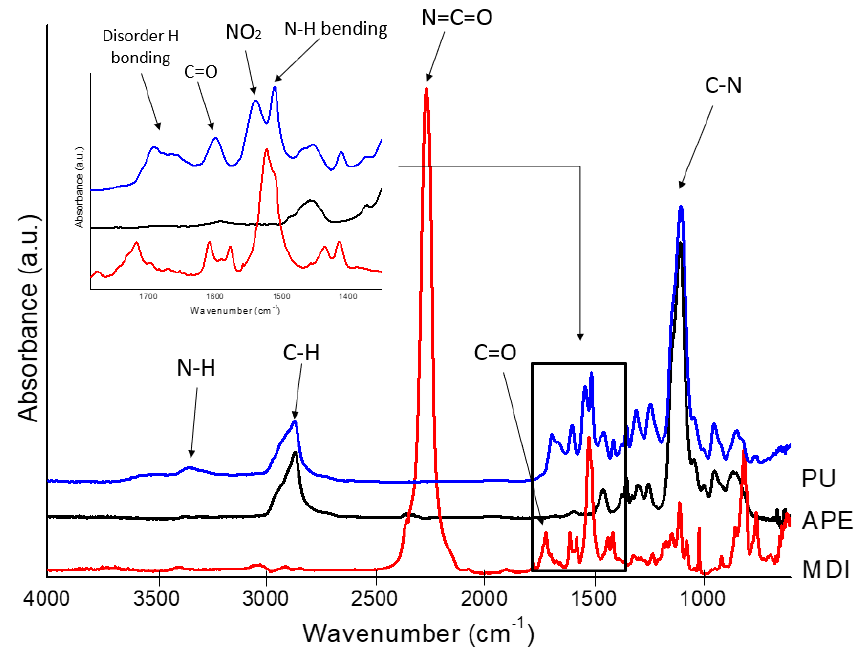
Figure 5. FTIR spectra for the polyurea matrix and raw materials used for its synthesis.